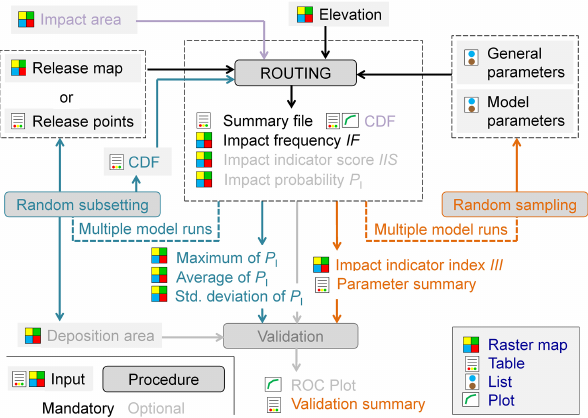
Figure 1. Logical framework of r.randomwalk. Only those compo- nents covered in the present article are shown.